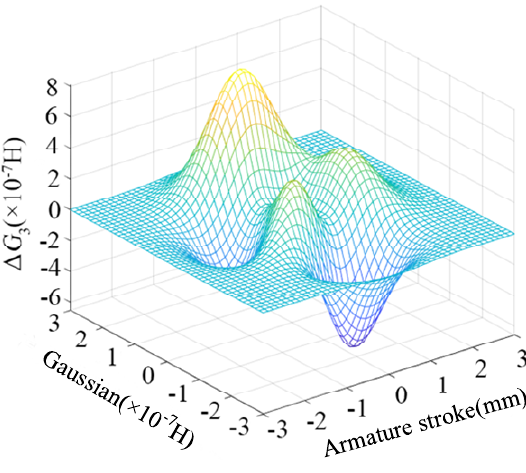
Figure 5. The basis function of Gaussian error data fitting.